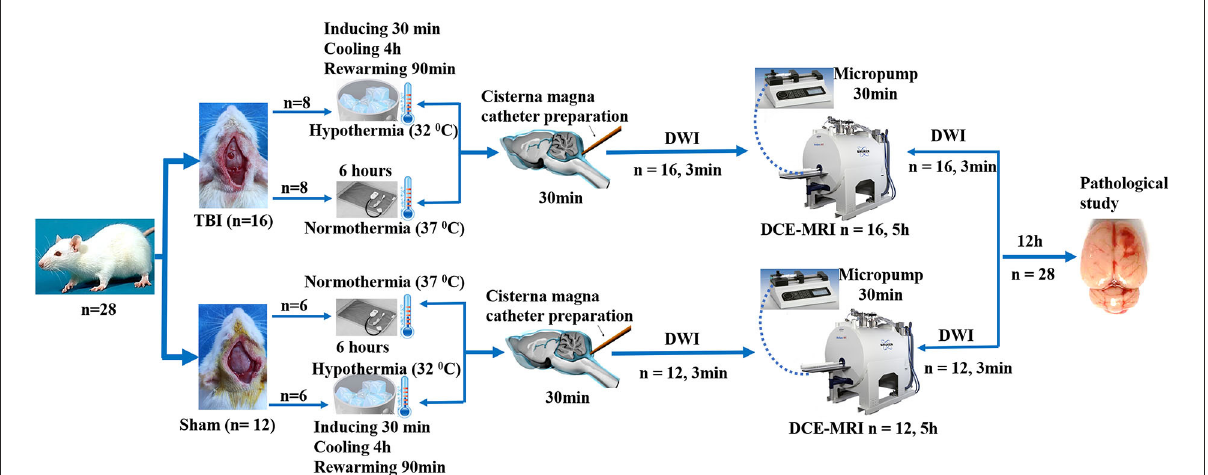
FIGURE1 Timeline schematic of the experimental layout where animals received TBI and Sham surgery, treated with hypothermia and normothermia, and then performed with diffusion-weighted imaging (DWI) sequences and a dynamic contrast-enhanced MRI (DCE-MRI) following intra-cisterna Magna injection of low molecular weight paramagnetic contrast